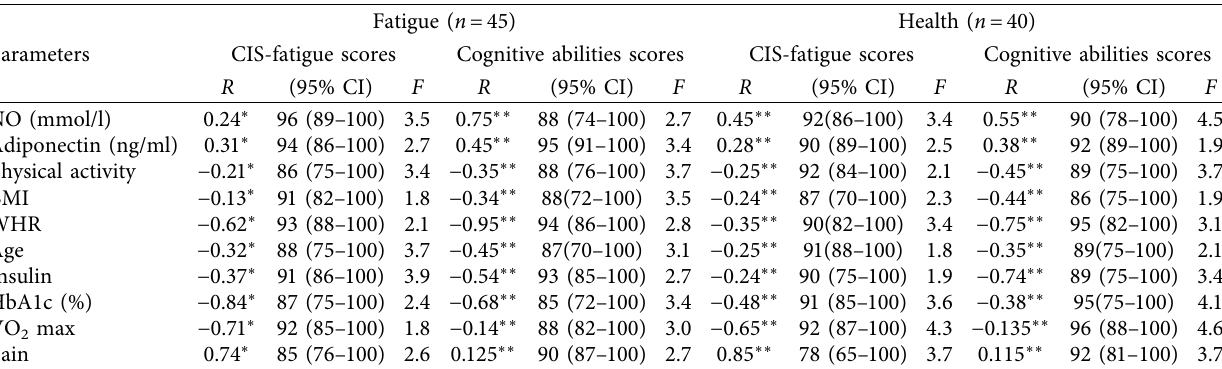
0.361, b P 0.01 for adiponectin when compared with normal healthy (cid:31) (cid:31) 85). (cid:31)